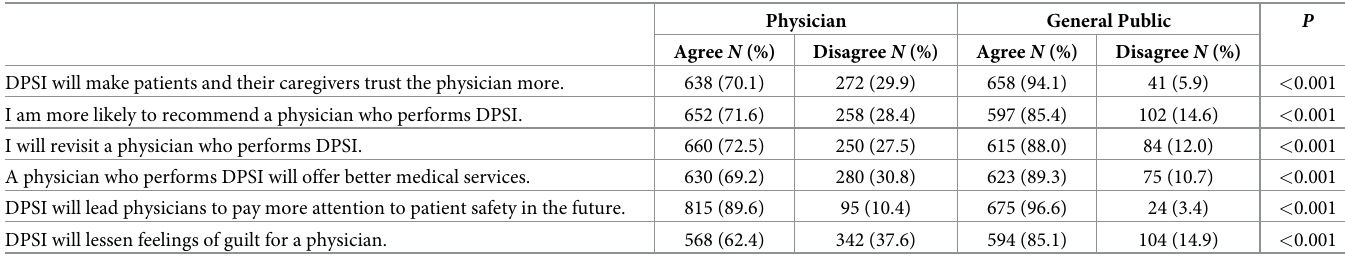
Table 4. Opinions on the effects of DPSI.